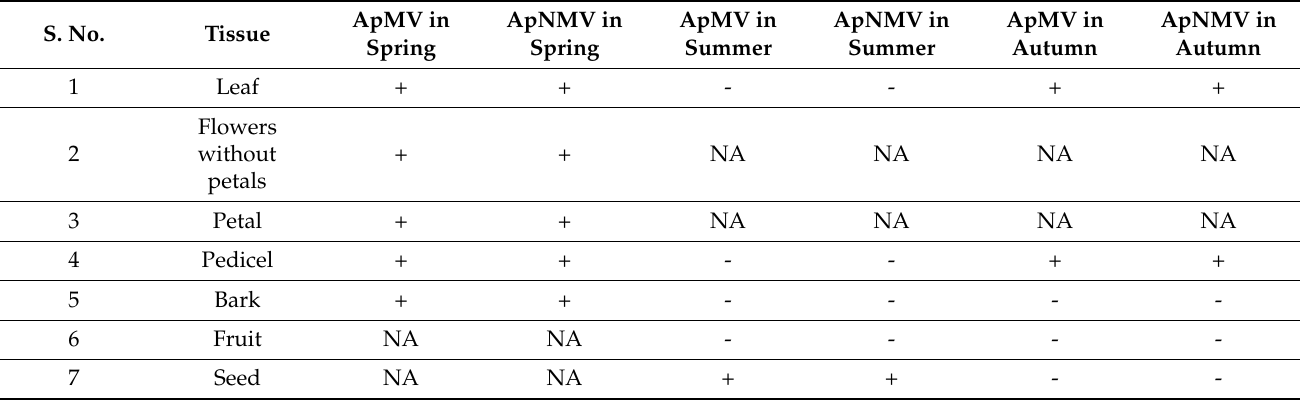
Table 1. Detection of ApMV and ApNMV in different parts of plants during different seasons in two cultivars through